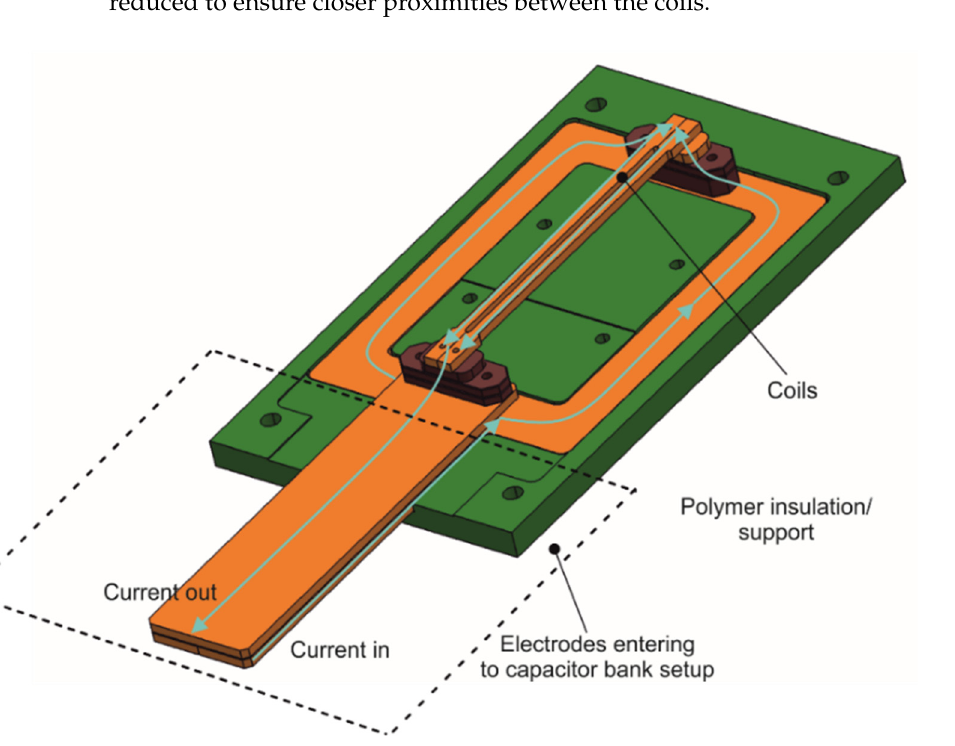
Figure 7. CAD model of the coil setup used for the experiments. The path of the current is shown in blue. Some support elements have not been shown for clarity of representation.